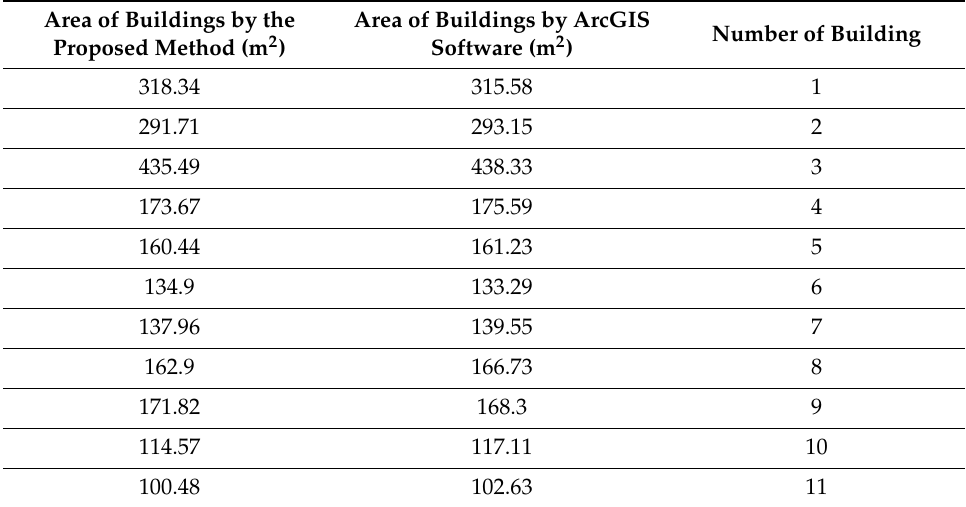
Table 4. Comparison of buildings area between the results and reference data from the USA. Area of Buildings by the